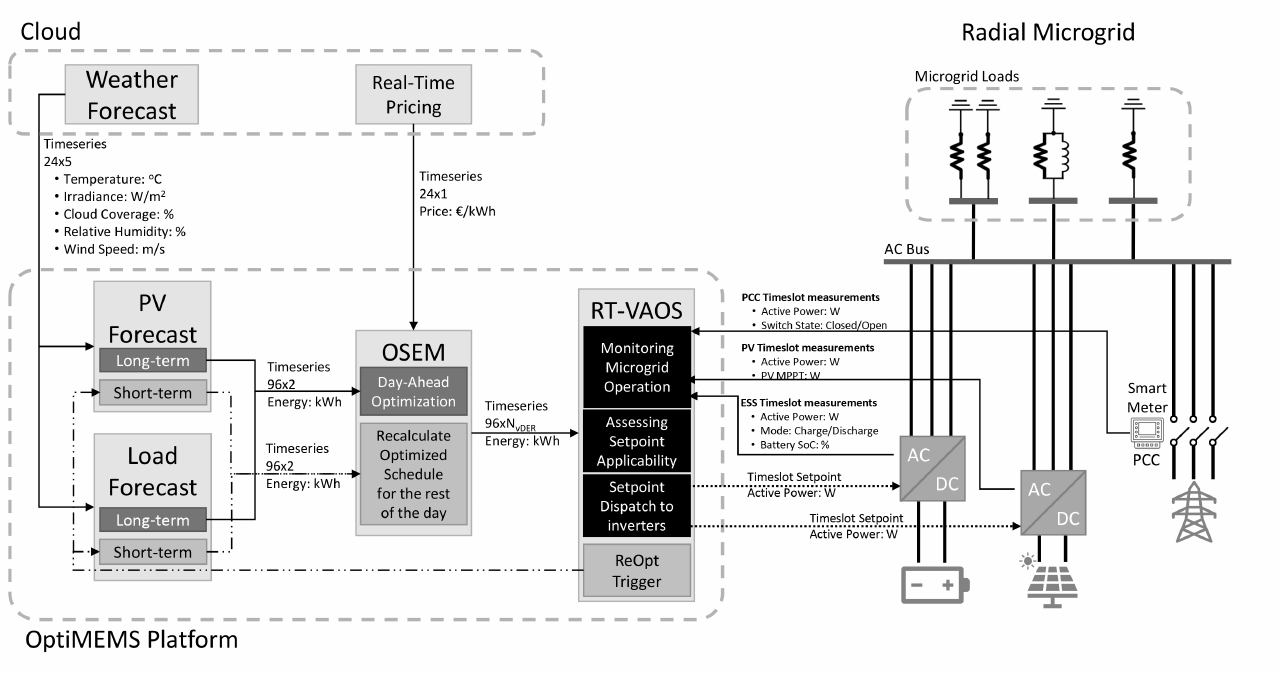
Figure 1. System Architecture of the OptiMEMS